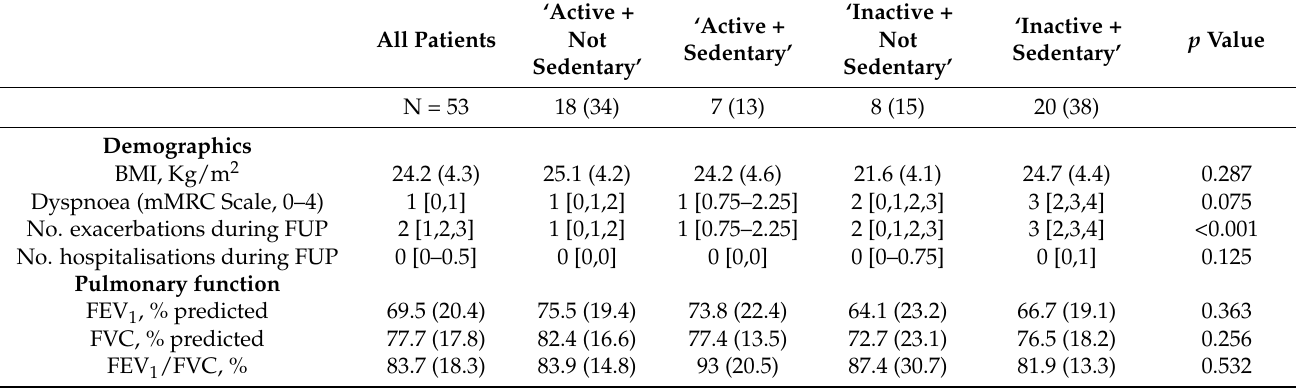
Table 2. Follow-up characteristics by physical activity and sedentary behaviour